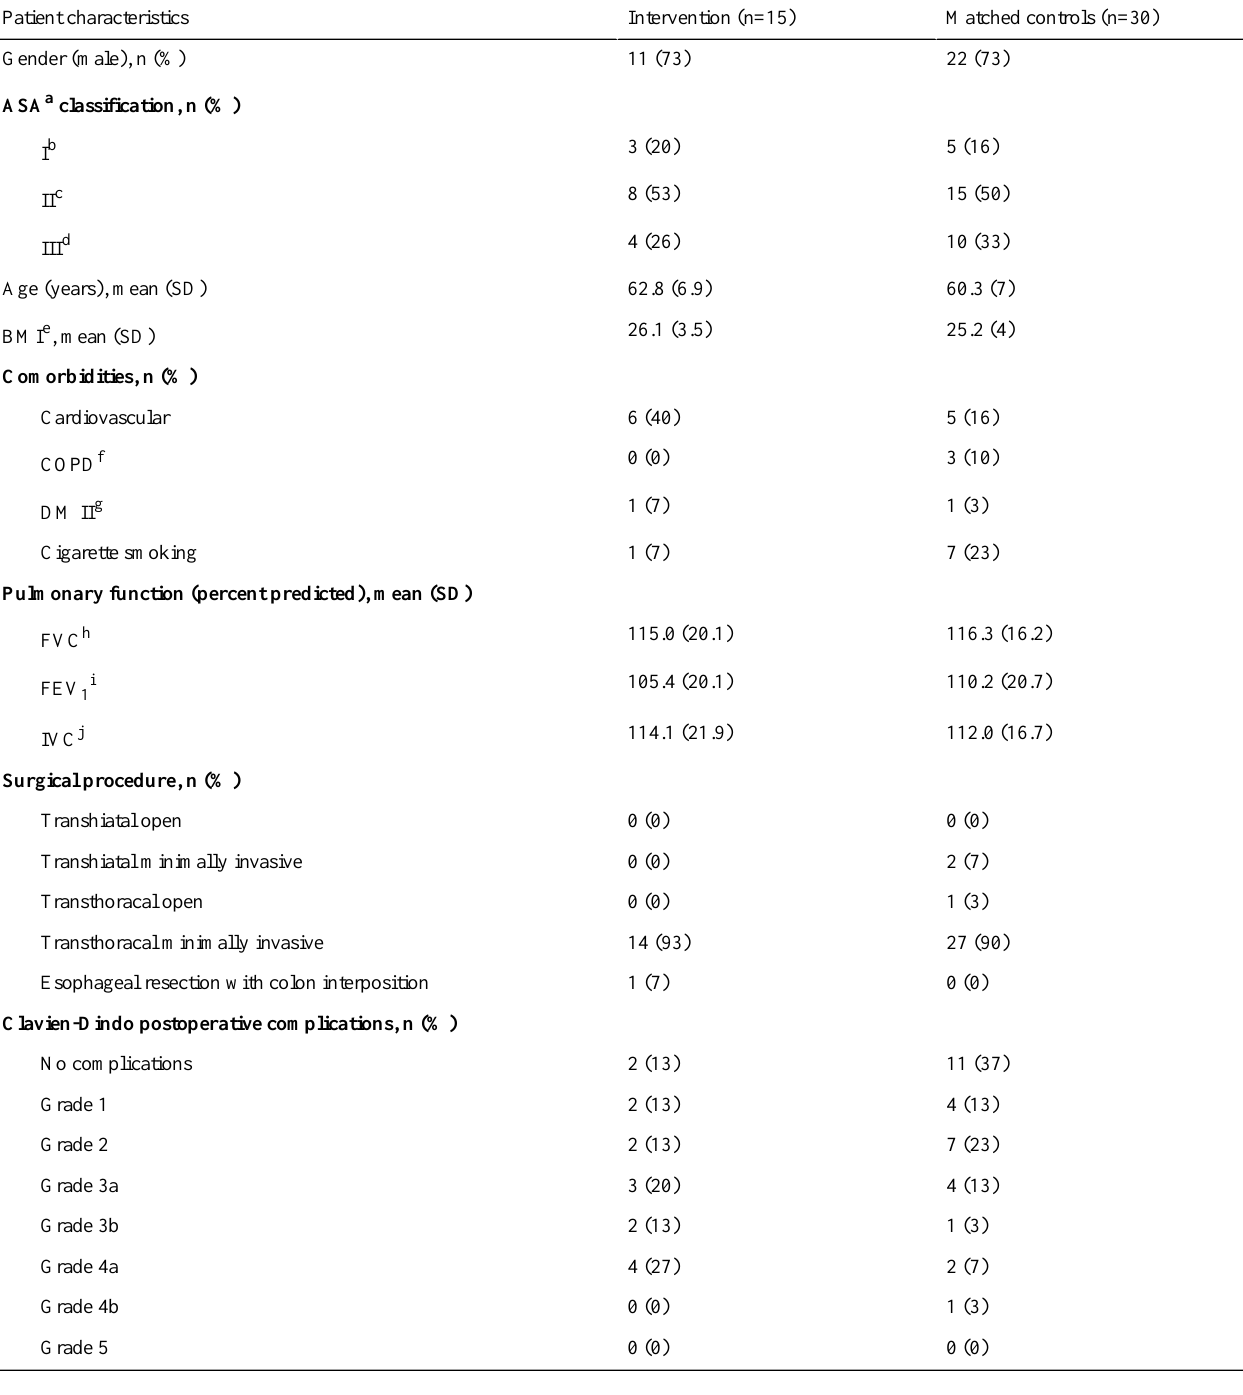
Table 2. Patient characteristics of the intervention group matched with a historical comparison